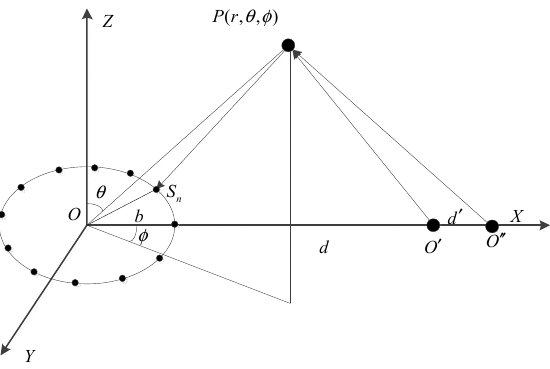
Figure 3. The radar geometry with two transmitters.